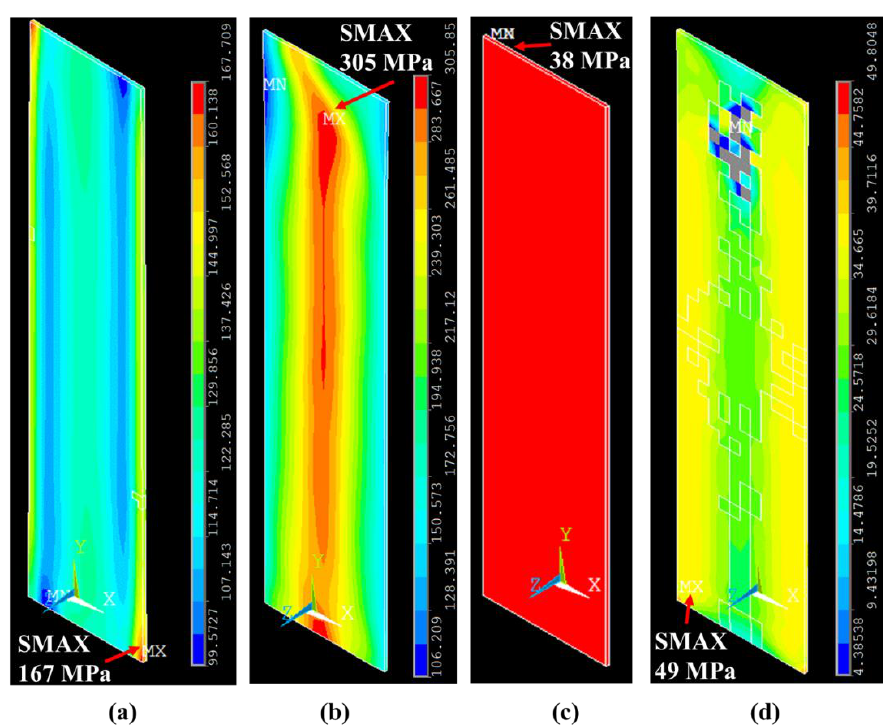
Figure 12. Contours for the Y-component of stress for 30° fiber orientation layer at 4.5% strain in a ( a ) single-angled GFRP composite and ( b ) multi-angled GFRP composite and thermoplastic layer at 3.2% strain in a ( c ) single-angled GFRP composite and ( d ) multi-angled GFRP composite, as revealed using the finite element method.